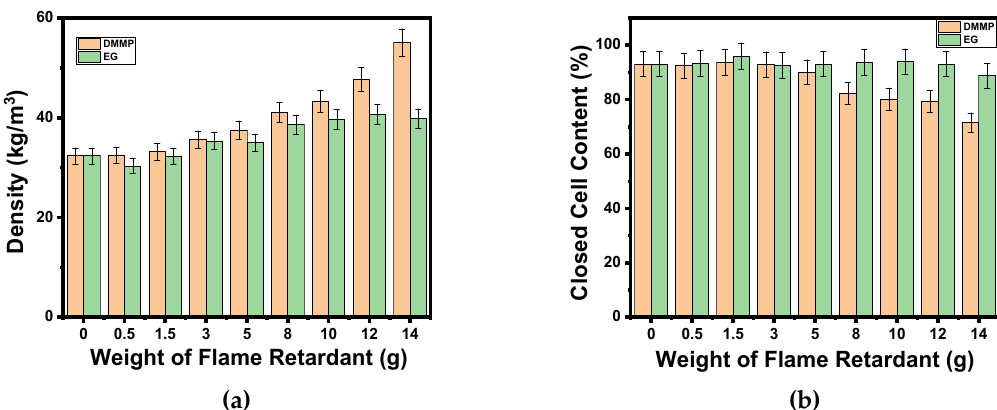
Figure 2. Variation in ( a ) density and ( b ) CCC of PU foams having various amounts of DMMP and EG as FRs. EG as